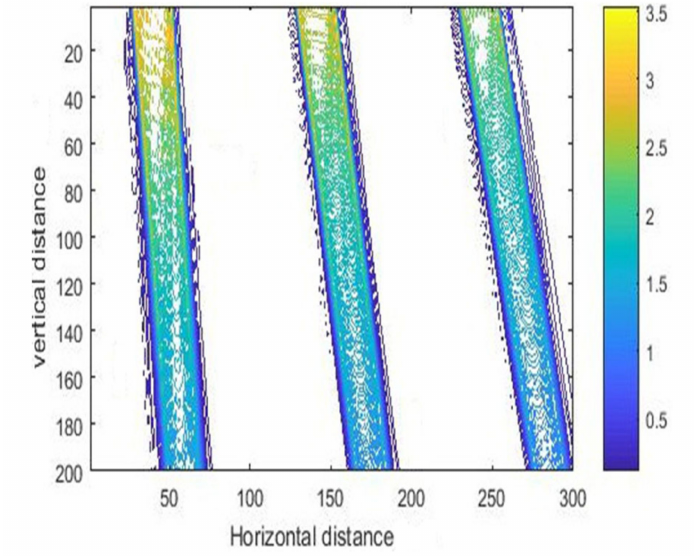
Figure 14. The contour map of intensity with di ff erent incident angles (15, 23.5, and 30 ◦ ) with air gap of 10 µ